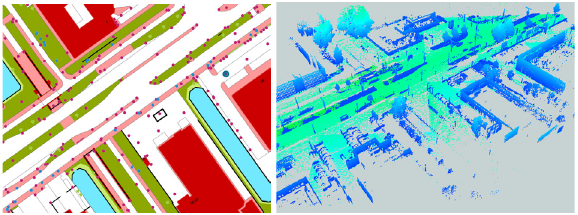
Figure 1. Large scale topographic map (left) and Mobile Laser Scanner data (right) of the same urban